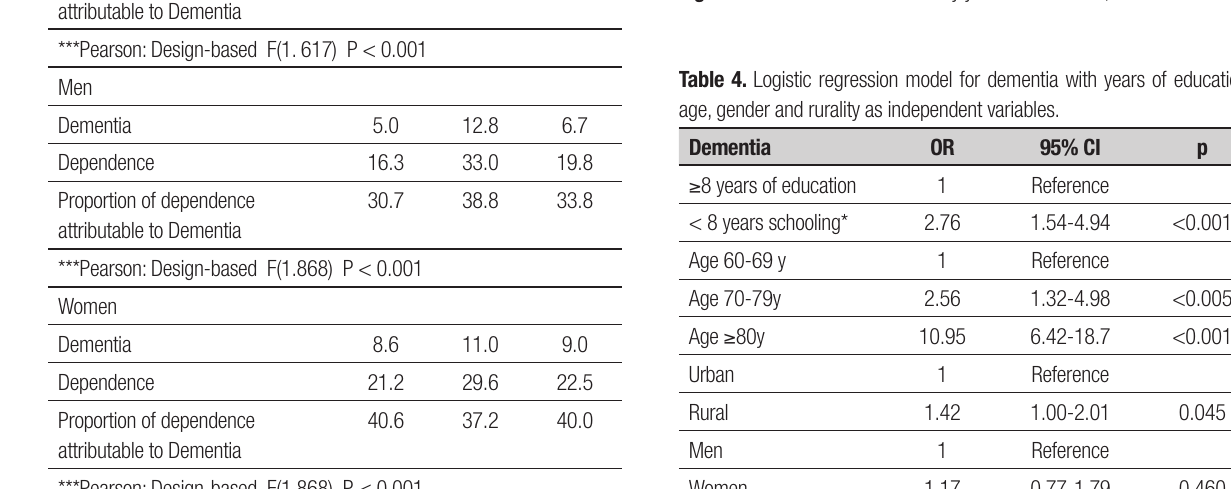
Figure 1. Prevalence of dementia by years of education, Chile 2010.